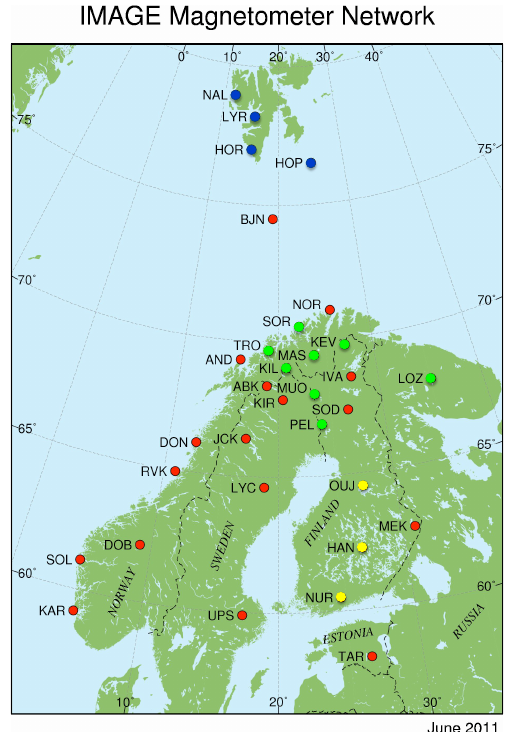
Figure 1. IMAGE magnetometer stations in 2011. The blue stations belong to Region 1, the green stations to Region 2 and Region 3 is marked with